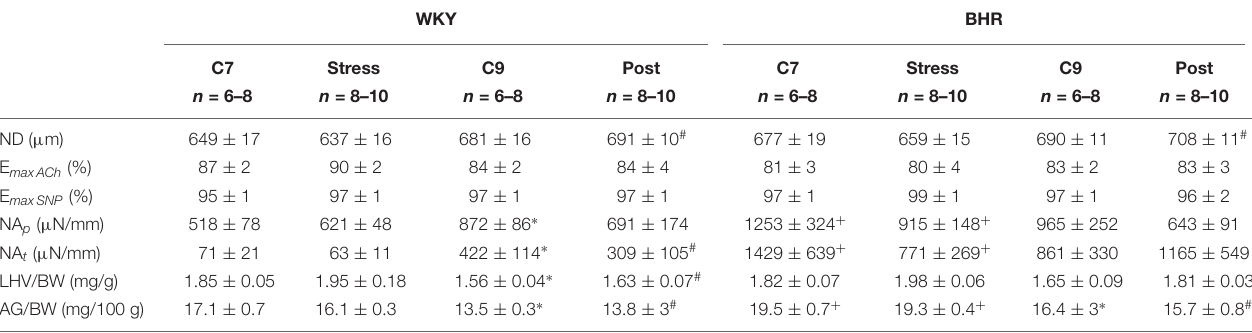
TABLE 1 | Biometric and vascular parameters of the femoral artery in normotensive Wistar-Kyoto (WKY) and borderline hypertensive rats (BHR). WKY